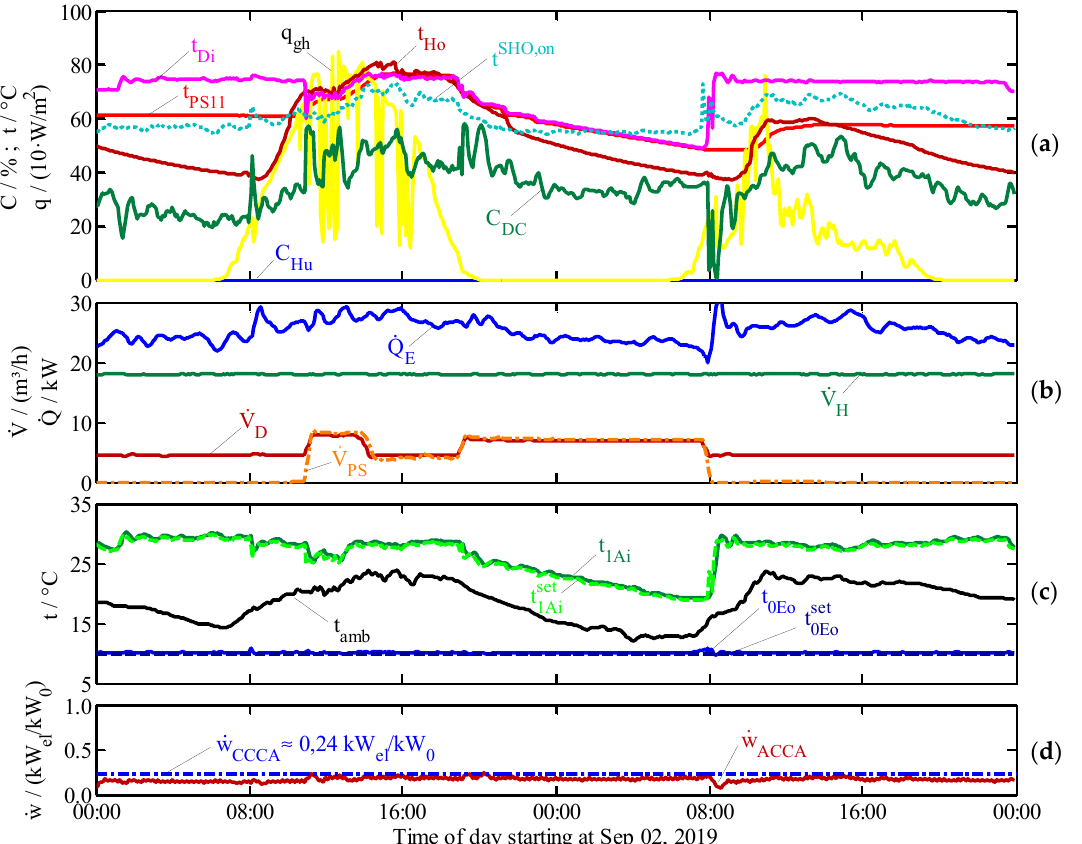
Figure 6. Solar heat operation over 21 h with the improved control strategy: ( a ) global horizontal irradiation, q (cid:2917)(cid:2918) , temperatures in hot water circuit and control signals from RHD; ( b ) flow rates and cooling capacity; ( c ) ambient air temperature and temperatures in the chilled and cooling water circuit; ( d ) specific electricity demand.